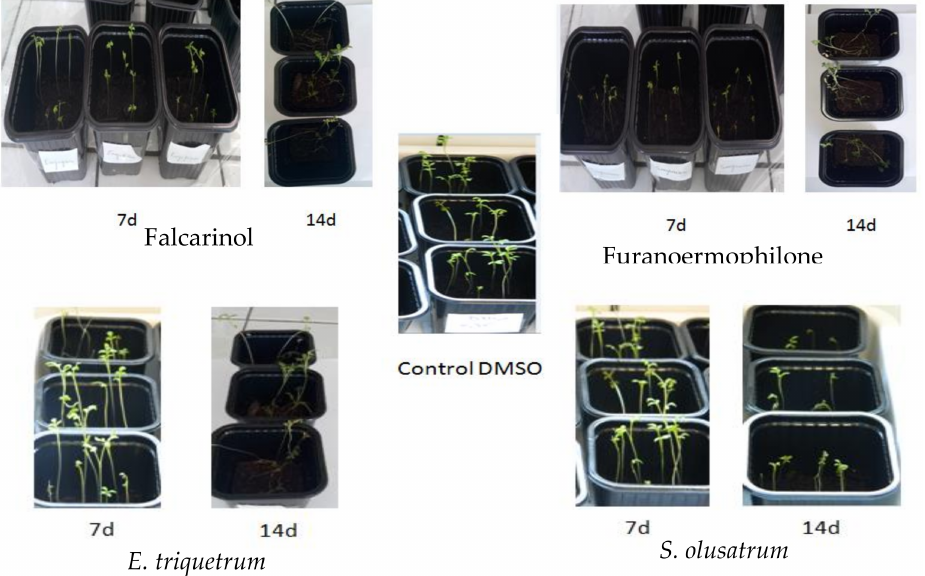
Figure 2. The effect of essential oils and major compounds on growth on model grass cress ( Lepidium sativum ) after 7 and 14